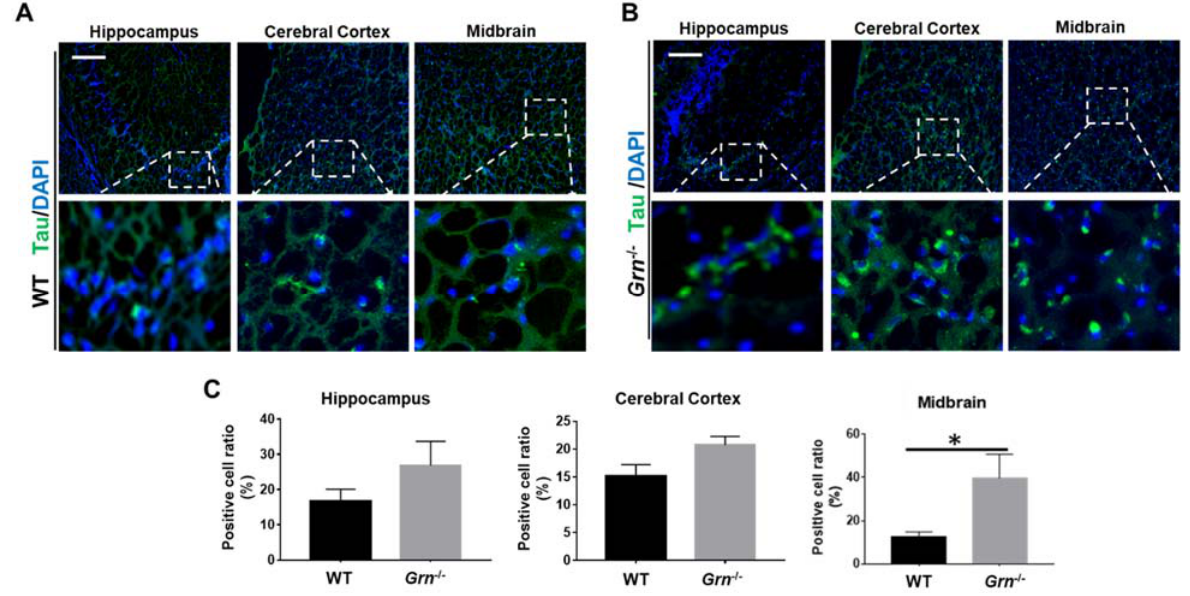
Figure 6. PGRN deficiency aggregated Tau in the CNS in aged mice. Tau antibody was used to stain the brain sections from 12 ‐ month ‐ old WT and Grn − /– mice. Distribution and accumulation of Tau positive cells were analyzed in three indicated brain regions using immunofluorescence staining. ( A , B ) Representative images of Tau accumulation in indicated brain regions of WT and Grn − /– mice. ( C ) The ratio of Tau ‐ positive cells per section were quantified of A and B. Scale bar: 100 μ m. n = 3. Data presented as mean ± SD. * p < 0.05.